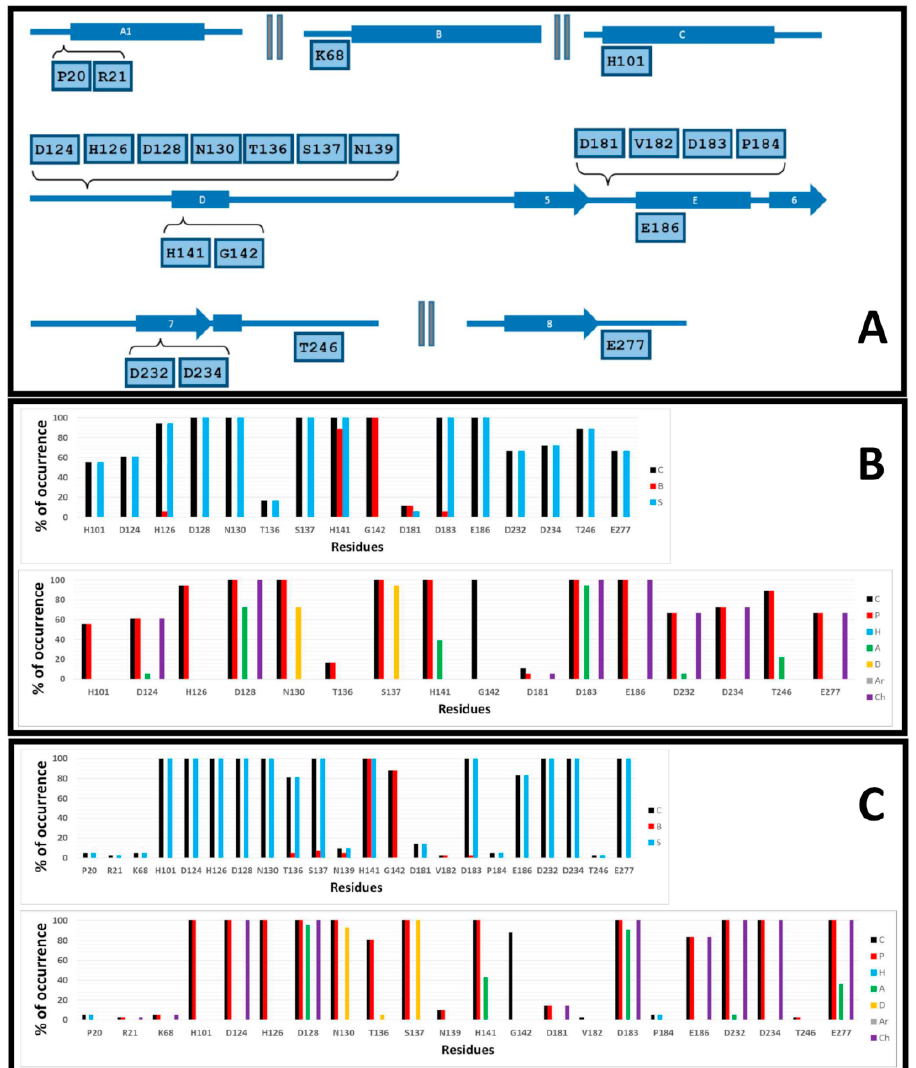
Figure 6. Occurrence of interaction types at the hARGI–ligand binding interface. ( A ) Residues with observed interactions, their position in the hARGI sequence. ( B ) Percent of occurrence of contacts C, interactions with the backbone of the residue B, and interactions with the side chain of the residue S (top); and percent of occurrence of chemical interactions: contacts C, polar P, hydrophobic H, HBs where the residue is acceptor A, HBs where the residue is donor D, aromatic Ar, and electrostatic with charged groups Ch (bottom) for the hARGI–ligand structures reported in PDB. ( C ) The same as ( B ) for the 42 hARGI–ligand structures obtained by docking.